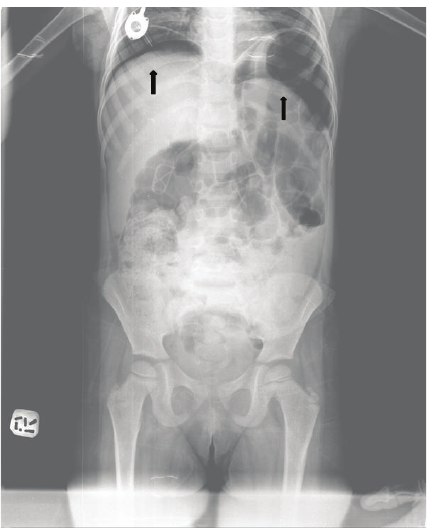
Figure 1: Plain abdominal radiograph shows subdiaphragmatic free air.